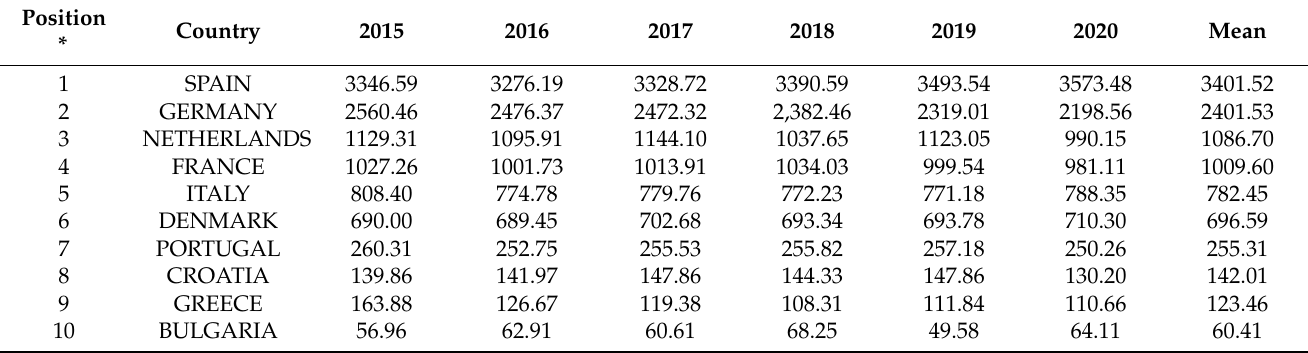
Table 9. Results of N 2 O emissions from manure management using GLEAM-i software (FAO, Rome, Italy) (Gg CO 2